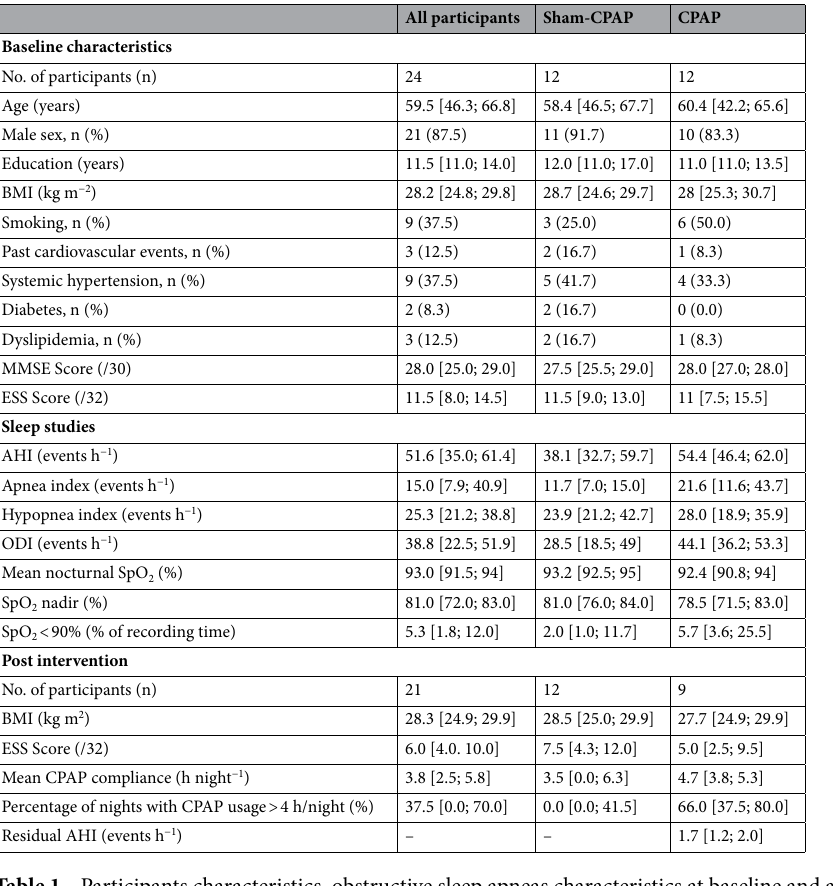
(including revascularization procedures), hospitalizations due to cardiac or cerebrovascular causes (acute coronary syndrome, stroke, heart failure, heart rhythm disorder including atrial fibrillation, bleeding, etc.). AHI Flow was measured using the CPAP machine’s internal microprocessor. Data are presented as median [Q1; Q3] or as number (%) of